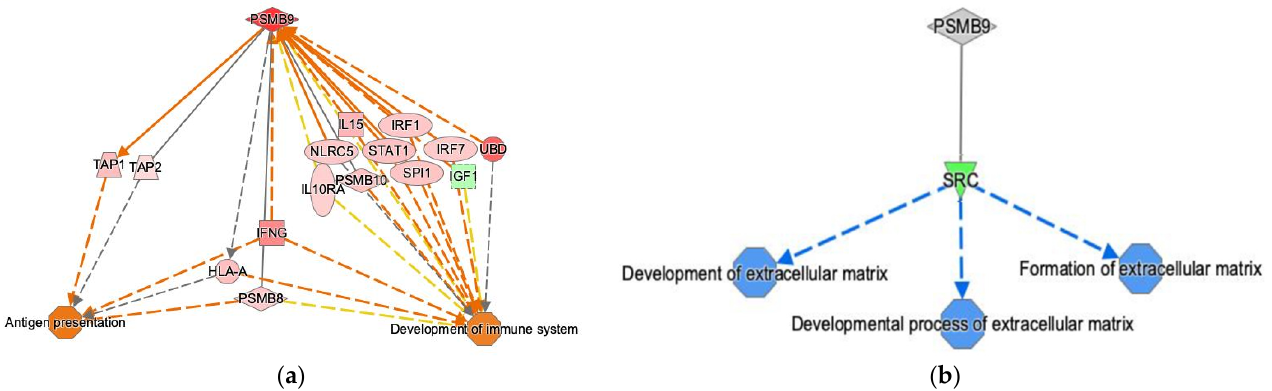
Figure 7. ( a ) Ingenuity Pathway Analysis (IPA) analysis of RNA-Seq data. Prediction of the effects in the high PSMB9 group. High PSMB9 gene expression level leads to activation of “antigen presentation” and the “development of the immune system” through IFN γ . ( b ) IPA analysis of the proteomics data. Prediction of the effects in the PSMB9 group. PSMB9 protein abundance is related to the development and formation of the ECM through SRC. Direct gene interactions are represented by continuous lines, while indirect relationships are represented by dotted lines.